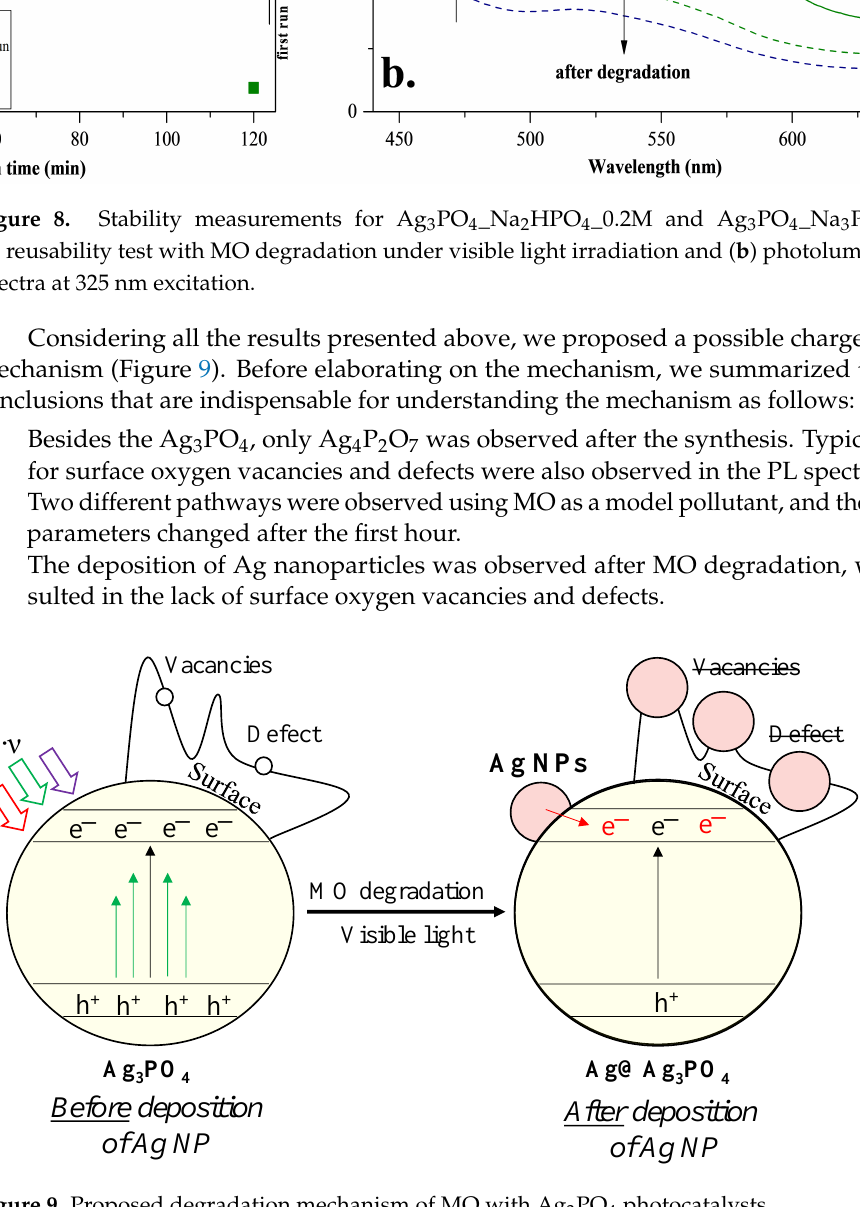
Figure 9. Proposed degradation mechanism of MO with Ag 3 PO 4 photocatalysts.